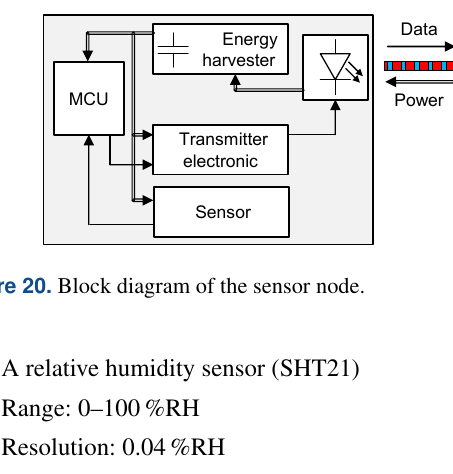
Figure 19. Central board hardware setup (Schuster, 2016).